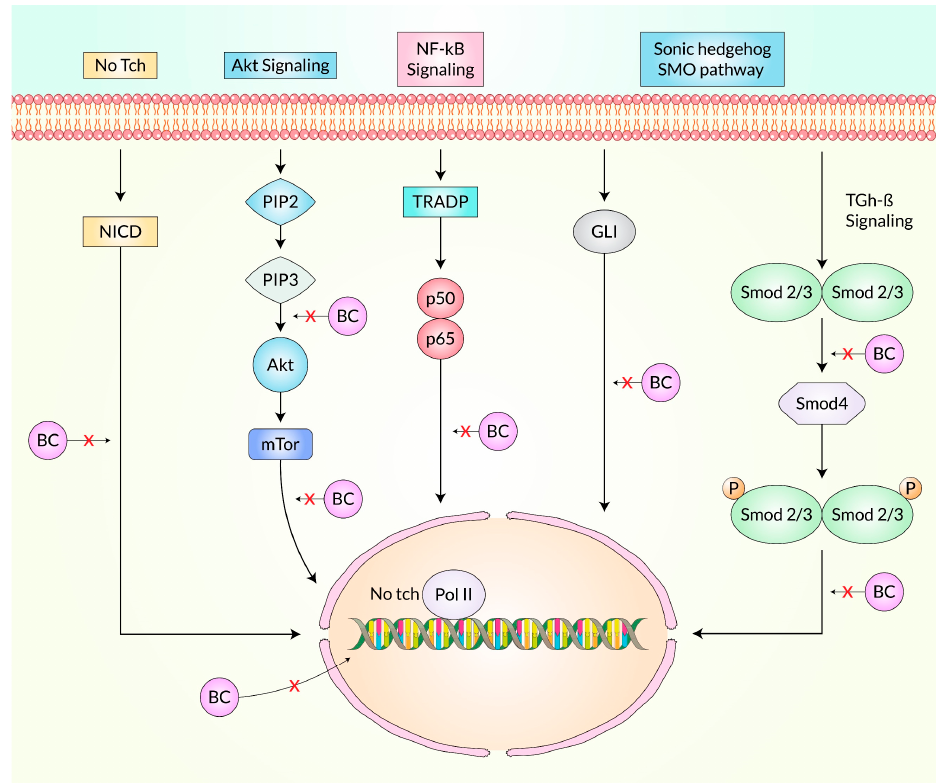
Figure 4. Effect of Baicalein on different signaling pathways. The schematic view represents the molecular mechanisms of Baicalein inhibiting cell proliferation through the Notch/Hes pathway. Cells undergo apoptosis following the treatment of Baicalein, which hampers the signal transduction between Akt and NF- κ B signaling pathways. CSCs lose their self-replicating feature after Baicalein treatment, downregulating the Shh receptor and effectors.